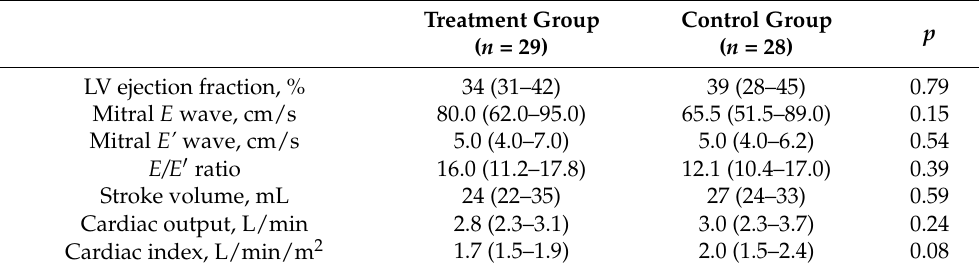
Table 2. Echocardiographic